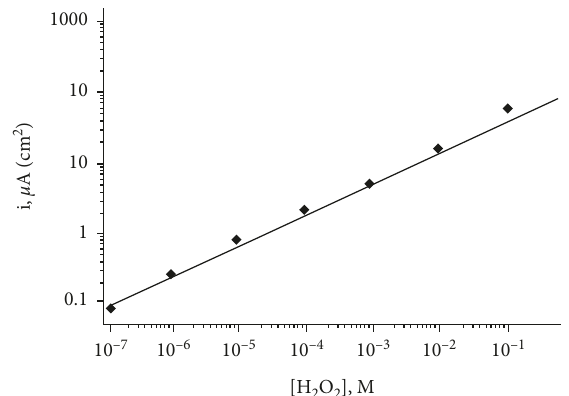
Figure 9: Calibration plot for H ified electrode.